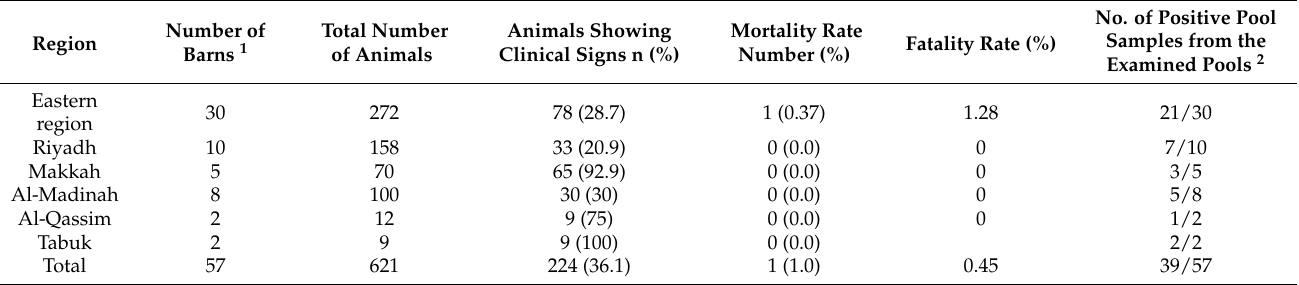
Table 1. Screening of equine influenza type A virus using real time PCR among horses from different geographical regions in Saudi